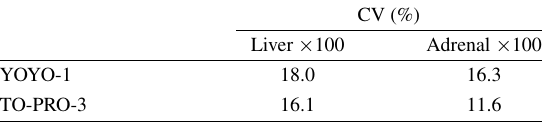
Comparison of coefficients of variations (CVs) of DNA histograms obtained with confocal laser scanning microscopy based 3D DNA cytometry (at × 60 or × 100 final magnifications) in normal adrenal